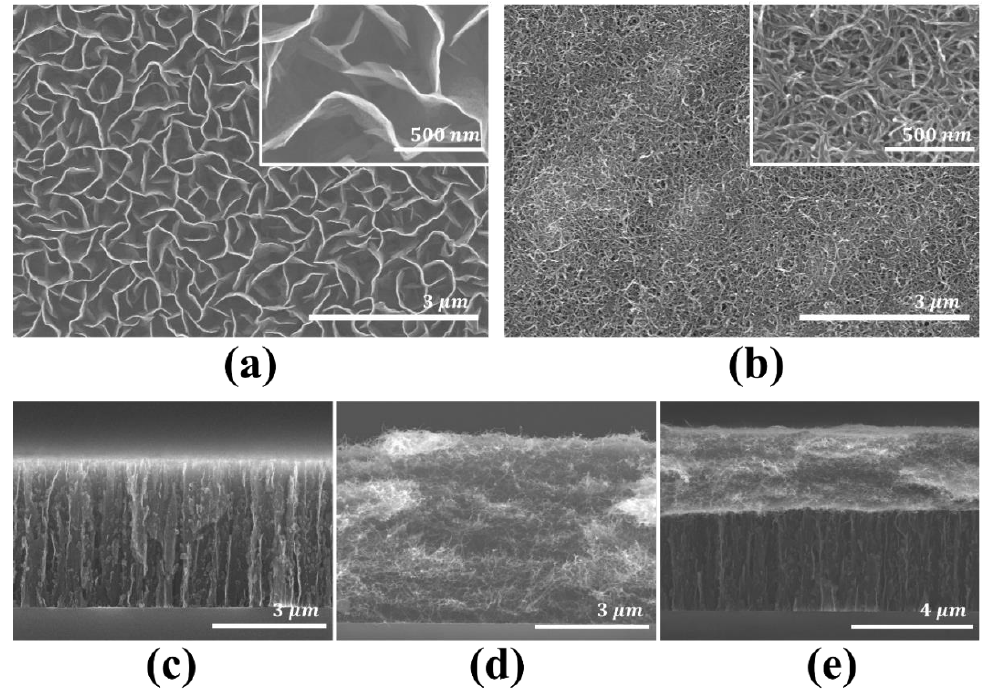
Figure 3. The FE-SEM surface image of the ( a ) CNW (scale bar, 3 µ m) with enlarged CNW (inset, scale bar, 500 nm) and ( b ) CNT (scale bar, 3 µ m) with enlarged CNT (inset, scale bar, 500 nm). The FE-SEM cross-section image of the ( c ) CNW (scale bar, 3 µ m), ( d ) CNT (scale bar, 3 µ m) and ( e ) composite material with CNW and CNT (scale bar, 4 µ m).